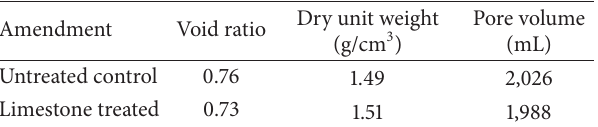
Table 2: Physical properties of the untreated and treated soils in the soil